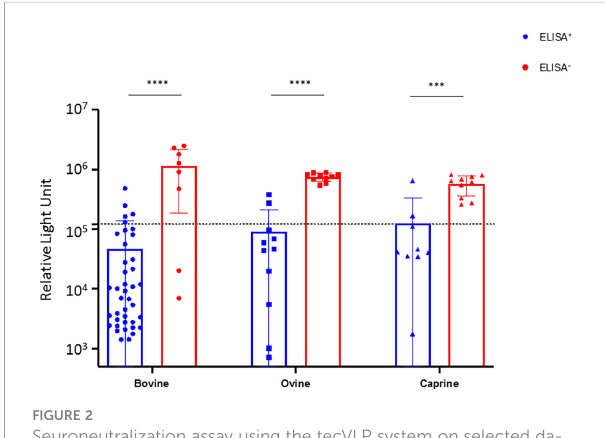
FIGURE 2 Seuroneutralization assay using the tecVLP system on selected da- ELISA samples. Bovine, ovine, and caprine sera from the ELISA+ (blue) and ELISA- (red) groups were analyzed using a CCHFV tecVLP-based neutralization assay. Neutralizing activities are expressed as RLU (relative light unit). Each dot represents one serum. Dotted line represents the threshold value. Results were statistically analysed using Graph Pad Prism, unpaired t-test. Asterisks show the signi fi cant difference. p-value < 0.005.